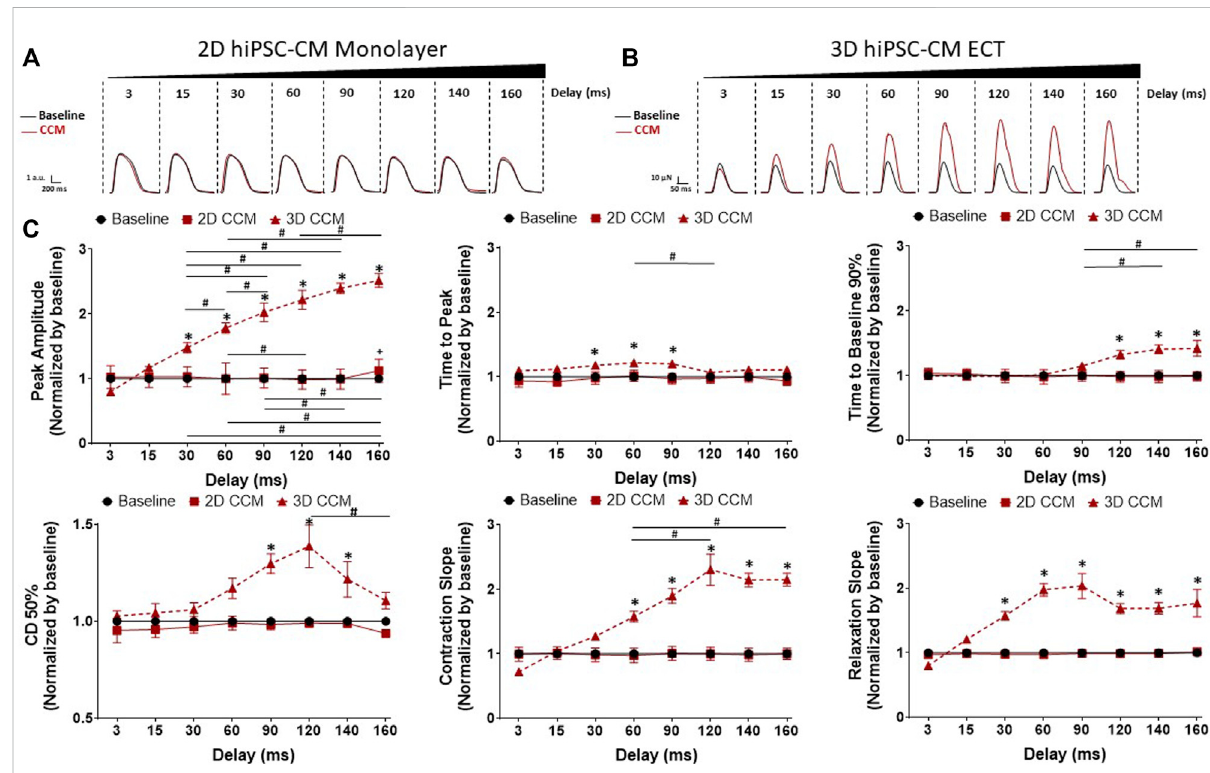
FIGURE 4 Effect of CCM pulse delay on 2D and 3D hiPSC-CM contractile properties (A) Representative contraction traces for baseline (i.e., fi eld stimulation pacing, 1 Hz). and CCM for 2D monolayer hiPSC-CMs and (B) 3D ECTs (C) Summary data graphs. Data are mean ± SEM. n = 3 – 6 per group. * p < 0.05 (3D vs. BL), # p < 0.05 (3D vs. 3D), + p < 0.05 (2D vs.